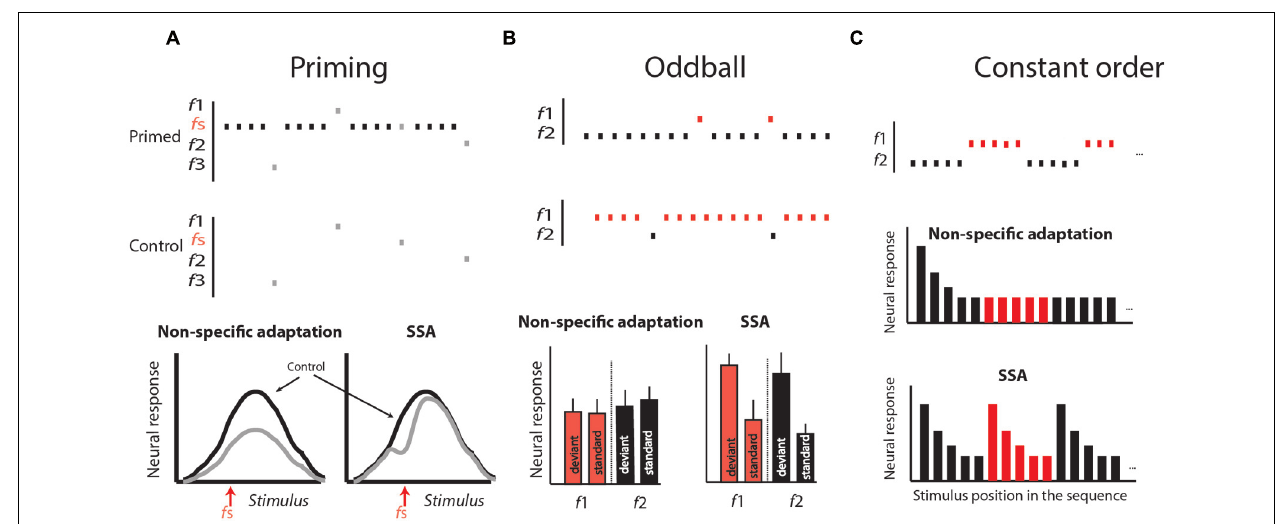
embedded with a relatively low probability. Later, a second block is presented in which the roles are changed: the stimulus that was standard is now deviant, and vice versa. At the end of the experiments, the average responses to the standards are compared with the corresponding responses to the deviants. In non-specific adaptation, we expect no significance differences (left histogram). In SSA, we expect the responses to the deviant to appear consistently above the responses to standards (right histogram). (C) The constant order protocol.Two stimuli are presented in a long sequence, starting with several repetitions of f1 then switching to several repetitions of f2, and so on, alternating between the two stimuli. In non-specific adaptation, we expect that the response to the first stimulus in each sub-sequence will be adapted and therefore not larger than the response to the same stimulus when it is last in the sequence. In SSA, we expect a stronger response every time the sequence is switched from one stimulus to the other (right histogram in C ). Modified from Gutfreund